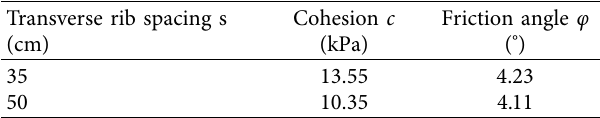
Transverse ribs spacing s=35 cm Transverse ribs spacing s=50 Figure 5: Relationship between interfacial shear strength and normal stress. Table 3: Strength parameters of geogrid-soil interface. Transverse rib spacing